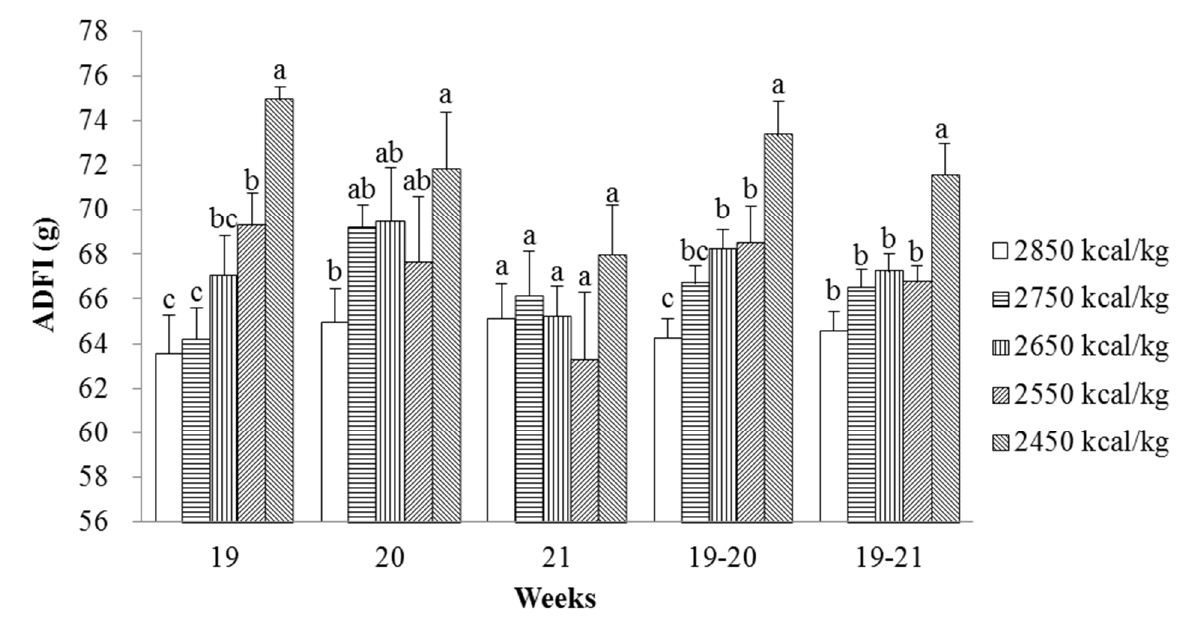
Figure 2. Effects of energy-restricted feeding and switching to ad libitum feeding on ADFI (g/bird per day) of the pullets from 18 to 21 weeks of age. Values are means of eight replicates per dietary treatment. Columns with different superscripts (a–c) are significantly different at p < 0.05. Table 4. Effects of energy-restricted feeding and switching to ad libitum feeding on ADEI (kcal AME n /day) and ECR (kcal AME n / g) of pullets from 8 to 21 weeks of age.